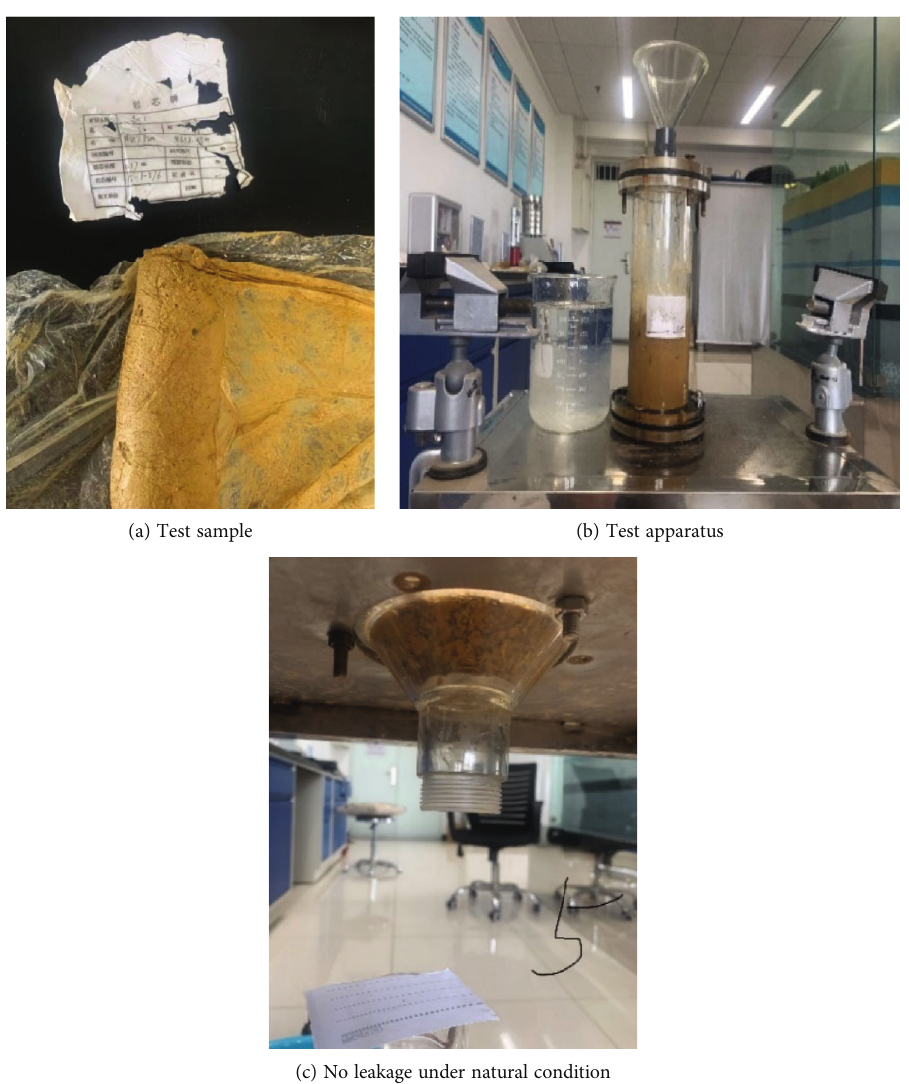
Figure 9: The leakage damage test under natural